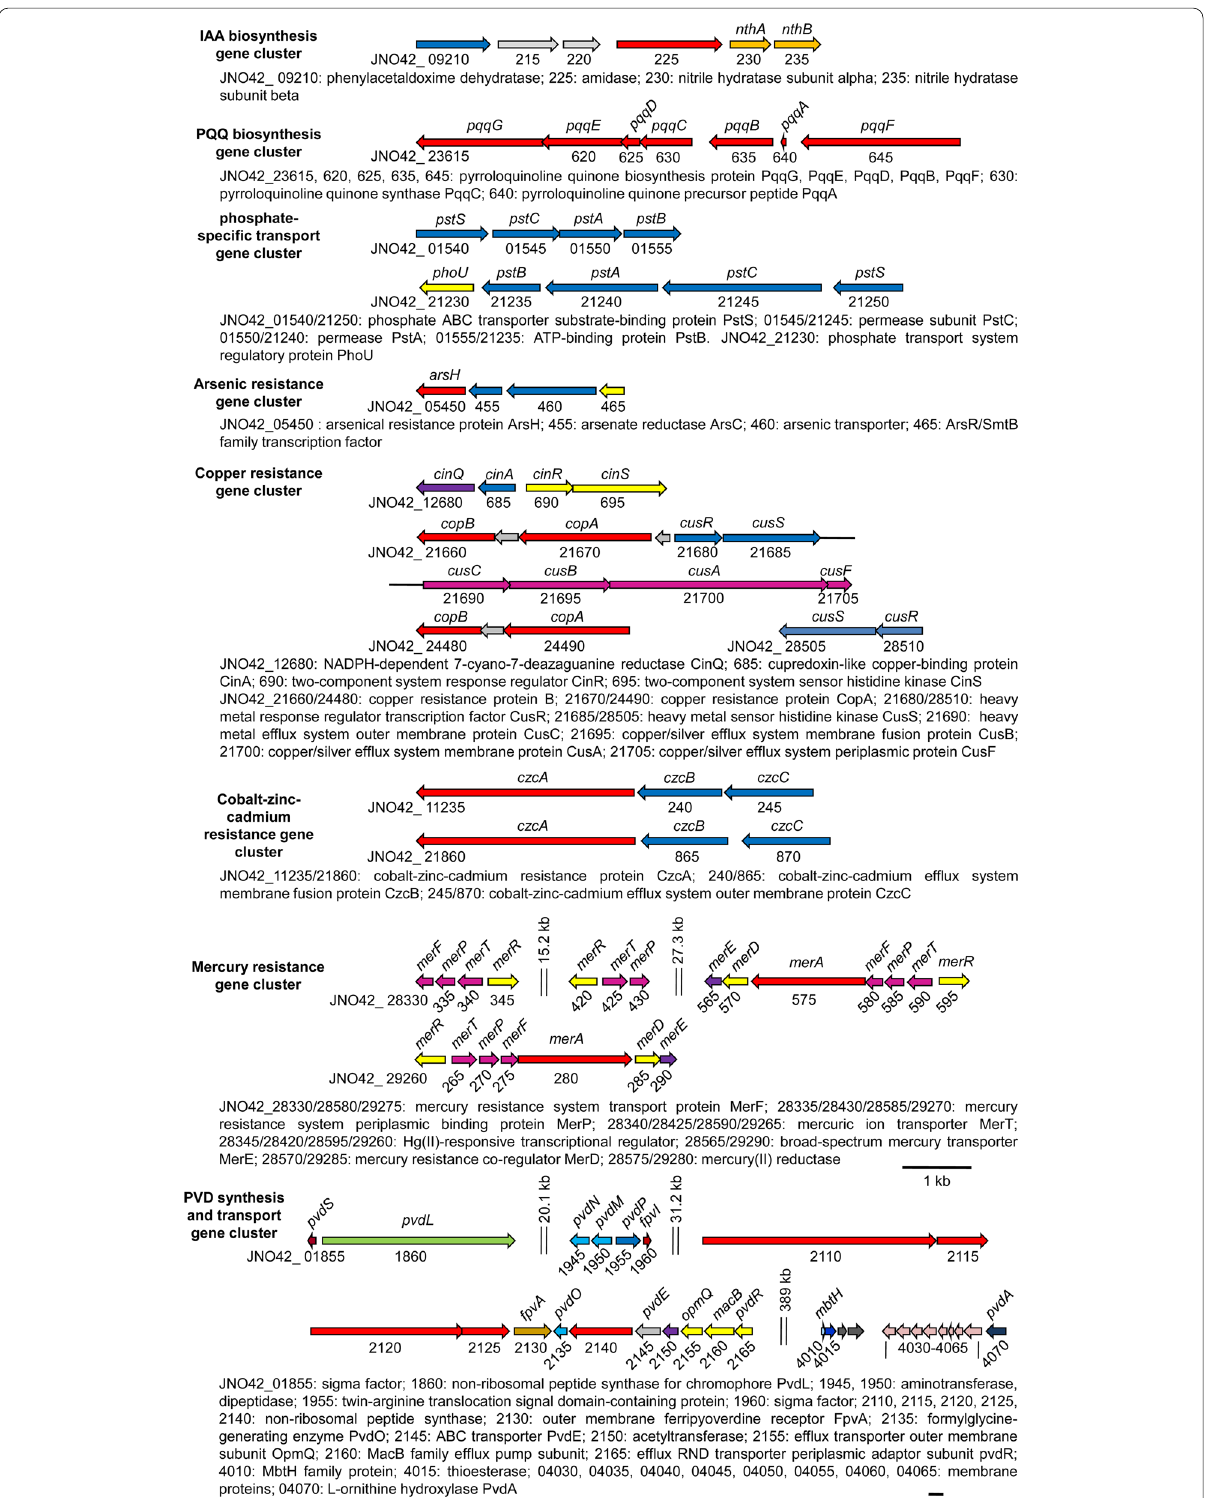
Fig. 6 Gene clusters associated with plant growth promotion and heavy metal resistance in P. putida